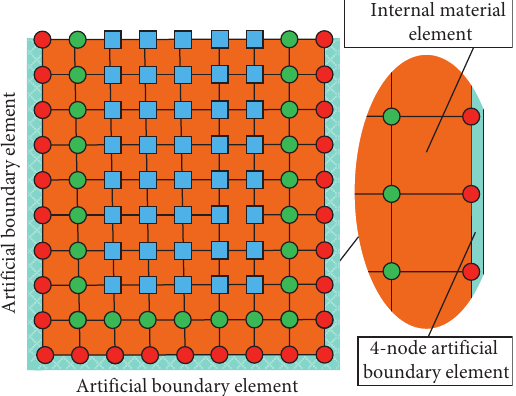
Figure 5: Artificial boundary element